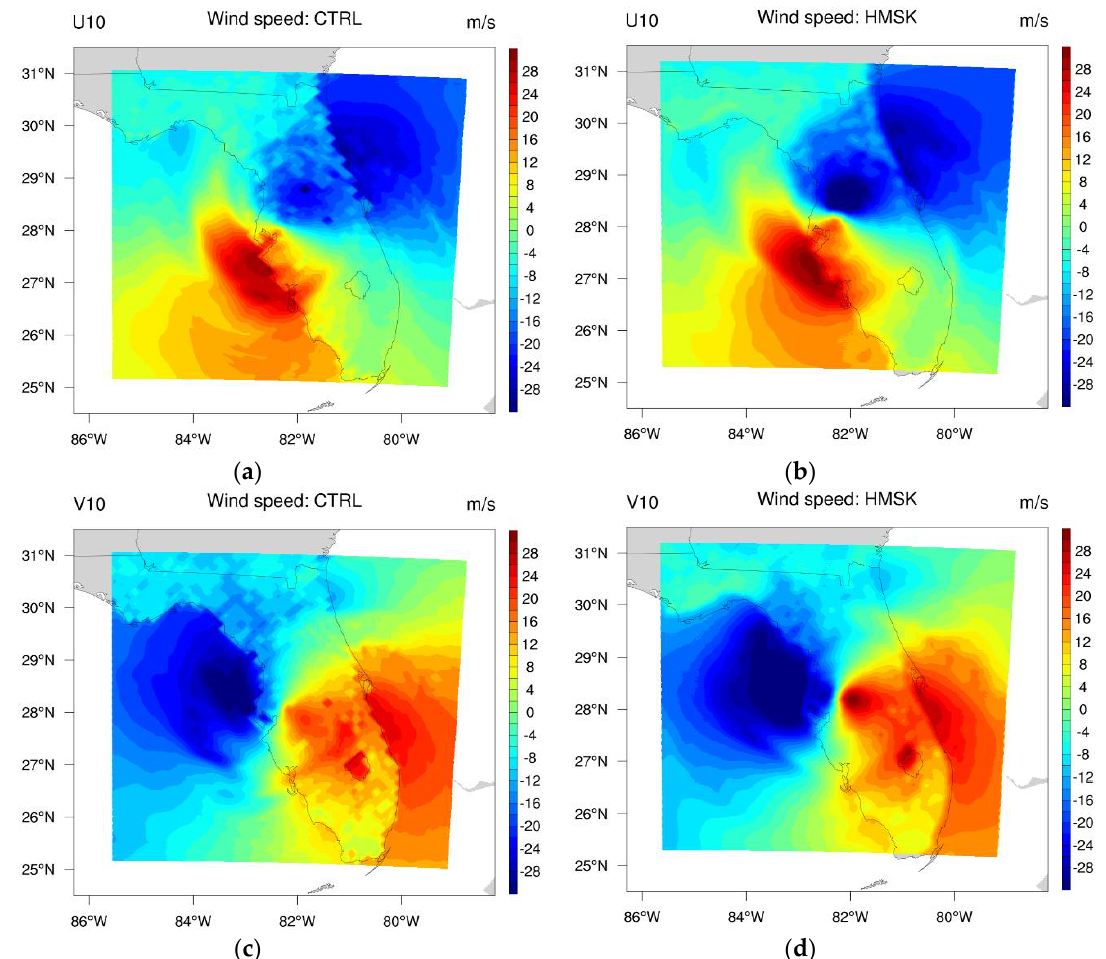
Figure 5. A comparison of 10 m U and V components of wind speed with/without the high-resolution land–sea masks within the innermost domain (d03) for Hurricane Irma (2017) at 0000 UTC, September 11, 2017. ( a , c ) U10 and V10 with the coarse resolution (13.5 km) of land–sea masks in the FY18 HWRF; ( b , d ) U10 and V10 with the high resolution (1.5 km) of land–sea masks.